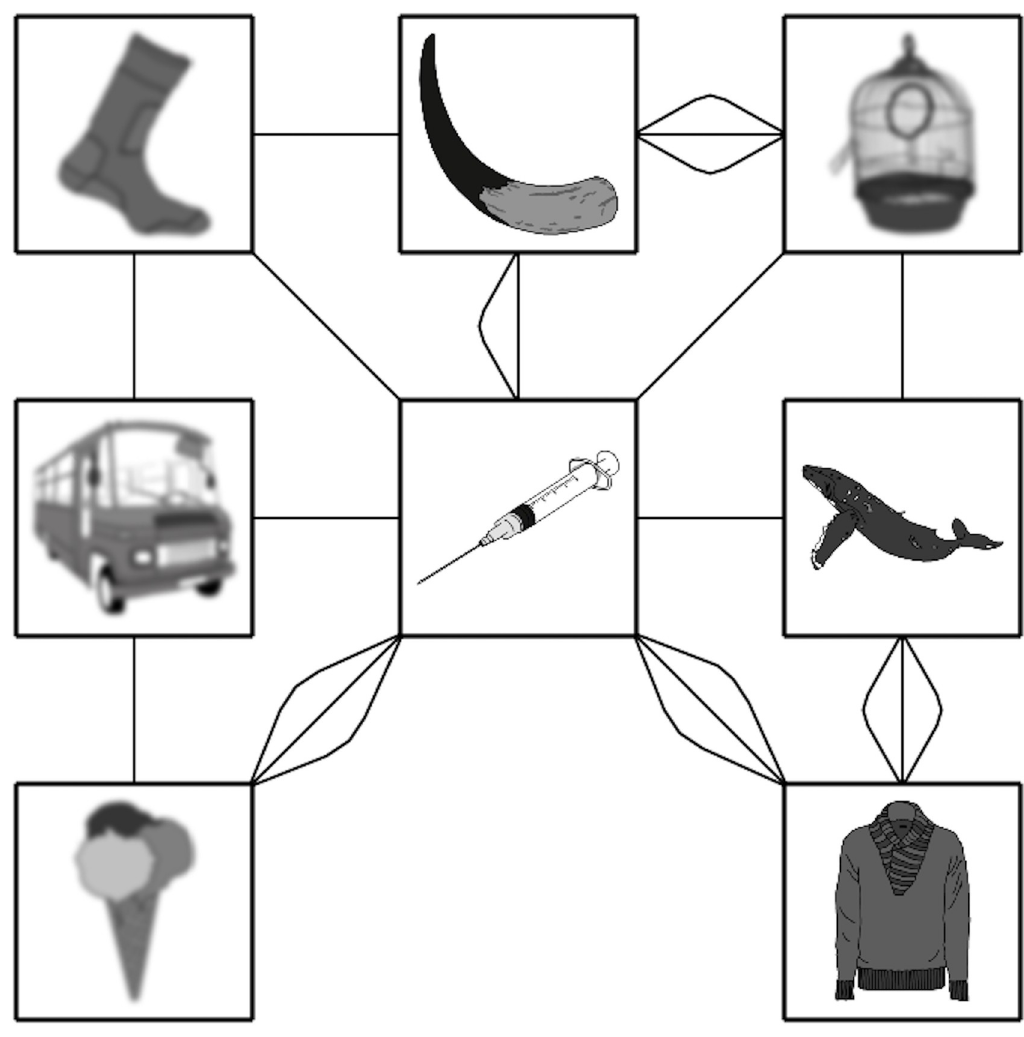
Fig 1. Example of a